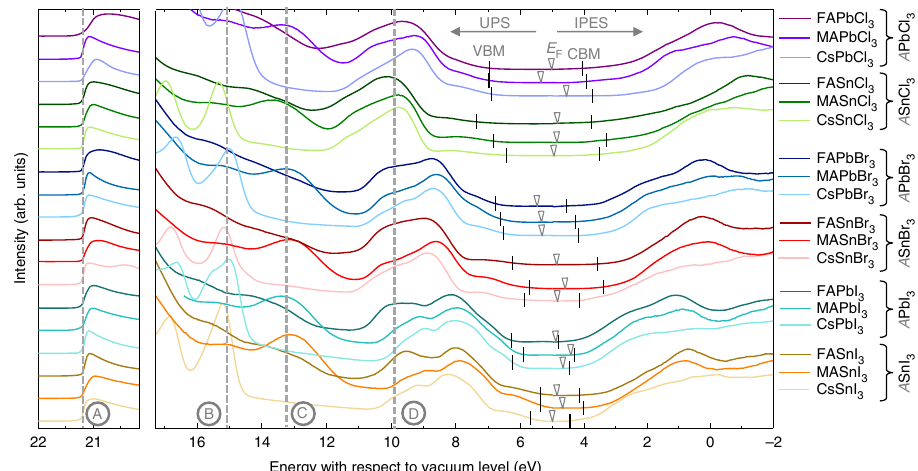
Fig. 1 Representative UPS and IPES spectra of all 18 metal halide perovskite systems. For better comparability, the curves are offset vertically and the high energy cutoffs are aligned at the excitation energy of 21.22 eV, marked by line A. Lines B, C, and D indicate characteristic features in the DOS, corresponding to the position of Cs, MA, and FA related states, respectively. The extracted positions of VBM and CBM are given by black vertical markers, and the Fermi level positions are marked by triangles. The procedure for evaluation of the exact positions of the VBM and CBM is elaborated in Fig. 2. Note that for IPES measurements only the smoothed data trend is shown (raw data are included in the Supplementary Fig.